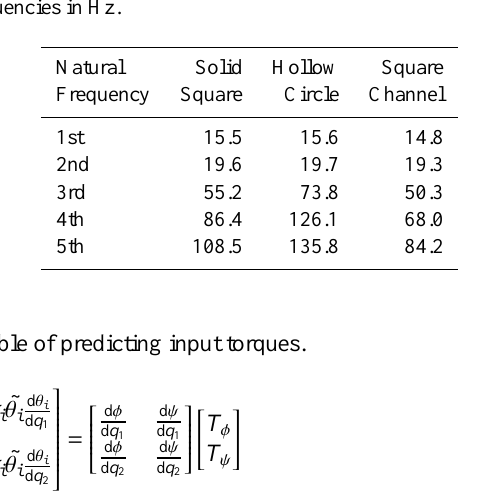
Table 4. Modal analysis of connecting structure sections. First and second frequencies correspond to the desired degrees of freedom. Frequencies in Hz.